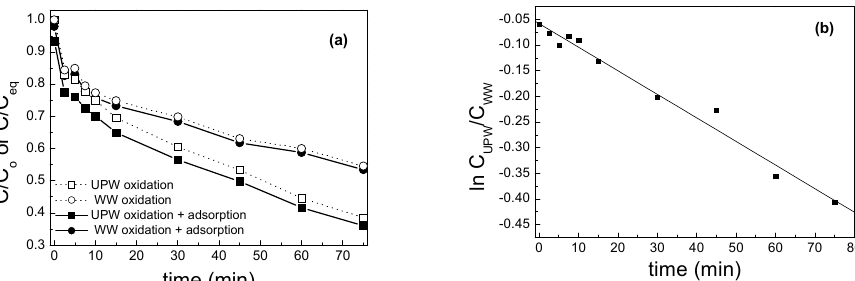
Figure 12. ( a ) Comparison between the actual oxidation and adsorption process and oxidation alone for SMX removal in UPW and wastewater (WW) with 200 mg/L biochar and 1000 mg/L SPS. ( b ) The linear dependence of the logarithm of SMX concentration ratio in UPW and WW.